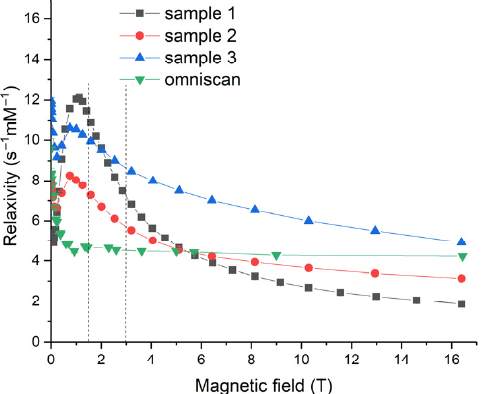
Figure 14. Magnetic field dependencies of relaxivity for the gadolinium-doped ceria nanoparticles (Samples 1–3) and Omniscan. The magnetic field values of 1.4 T and 3.0 T are marked as dashed vertical lines.